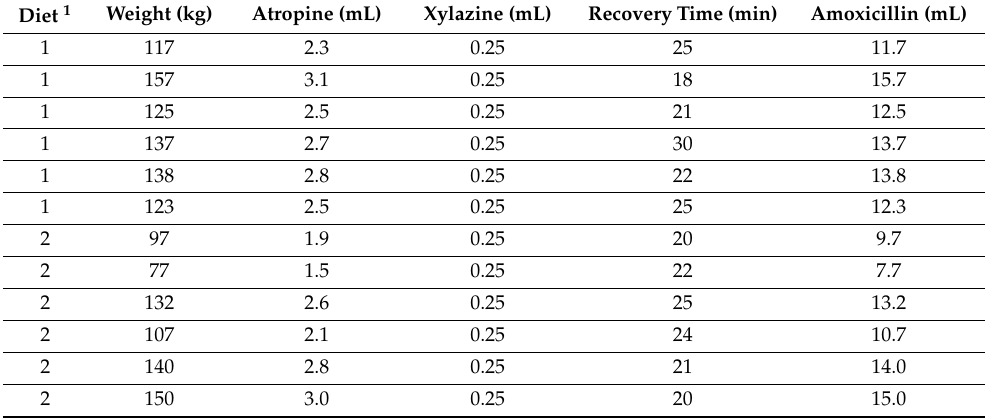
Table 1. Anesthesia, recovery time, and medication used in calves during the oral endoscopic biopsy procedure.